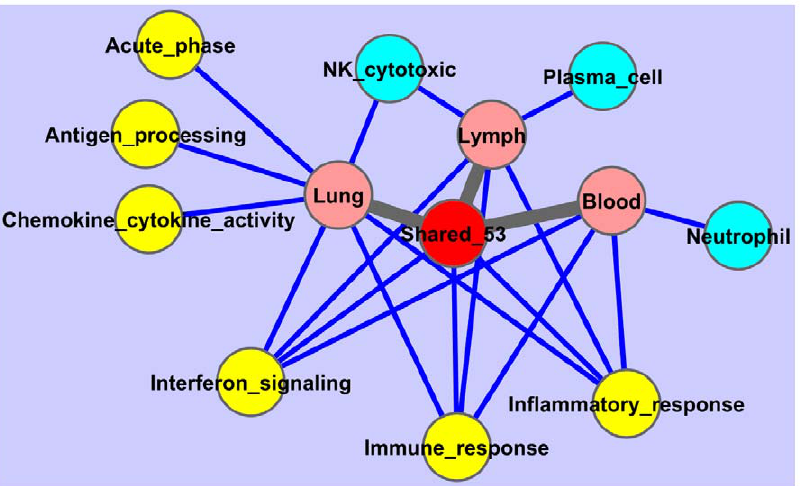
Figure 2. Functional enrichment for lung, lymph node, and blood responses. Nodes represent tissue responses (pink), shared primary response (red), GO/UniProt functional terms (yellow) and immune cell type (light blue). Edges represent significant (p , 0.01) enrichment (dark blue) or a subset relation (gray).